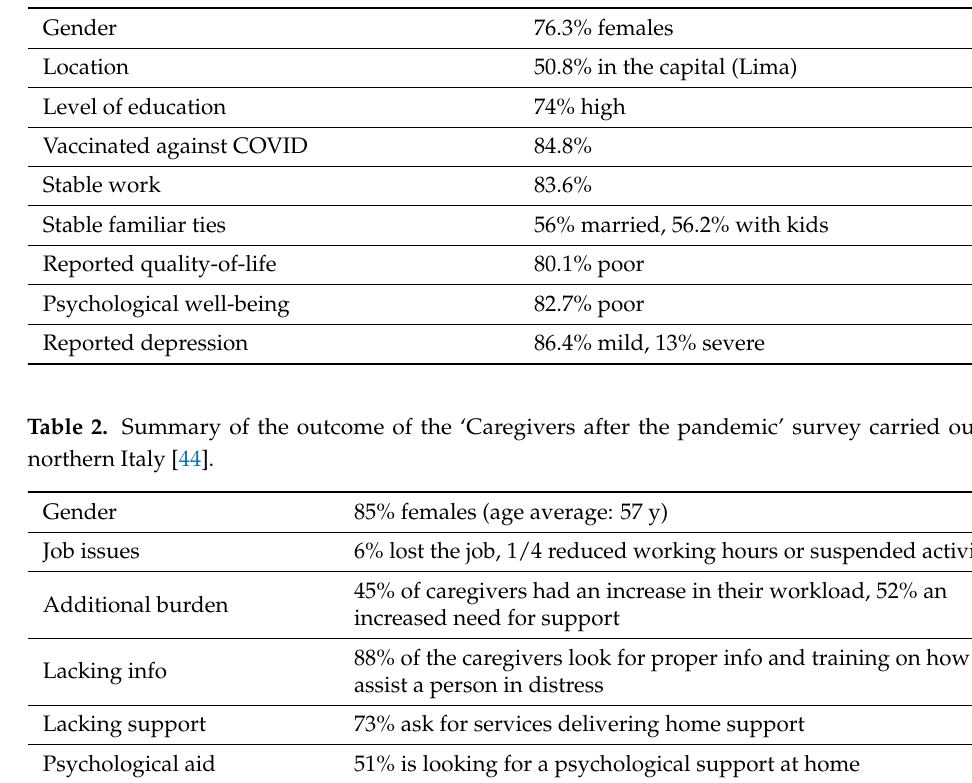
Table 1. Summary of the outcome of the survey carried out in Perou [40].